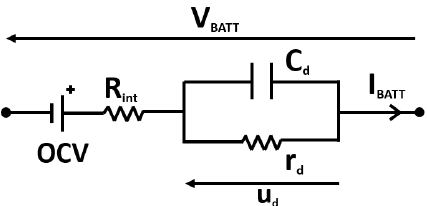
Figure 5. First-order electrical model of a Li-B cell.